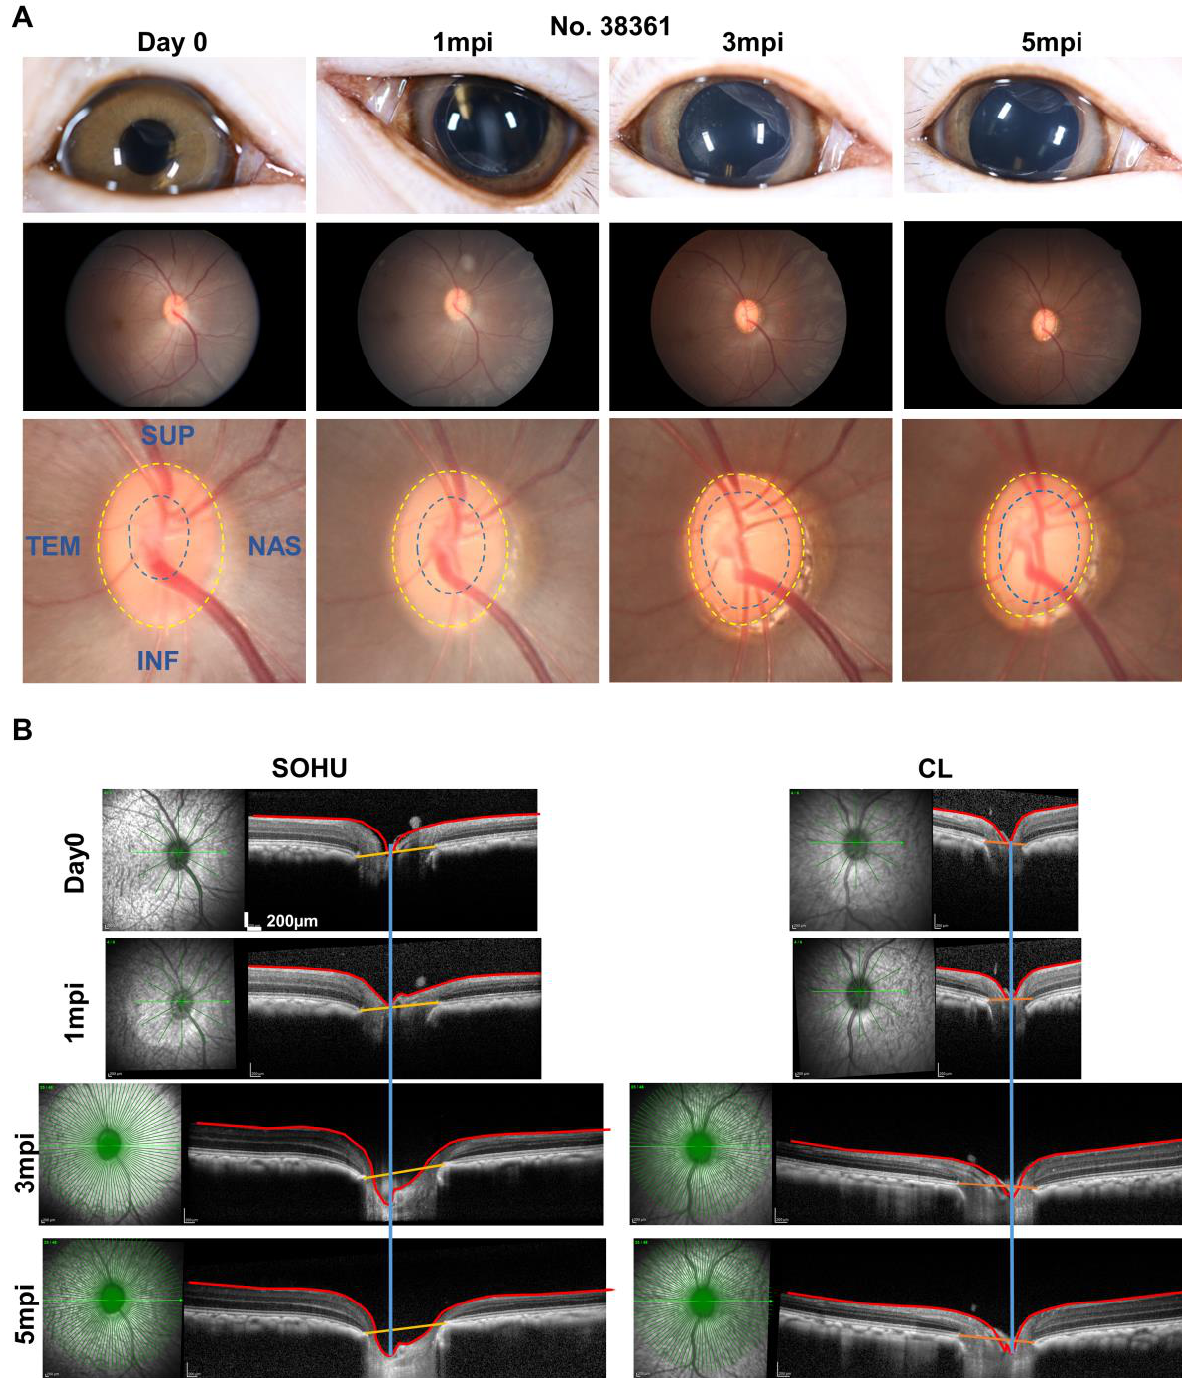
Figure 6. ONH “cupping” in animal #38361 associated with IOP elevation. ( A ) The retinal fundus images of the SOHU eye before and after SO injection. Yellow dotted line outlines the optic disc; blue dotted line outlines optic cup; ( B ) Longitudinal SD-OCT imaging of macaque ON head with 48 radial B-scans acquired over a 30° area at 768 A-scans per B-scan, ART = 16 repetitions.